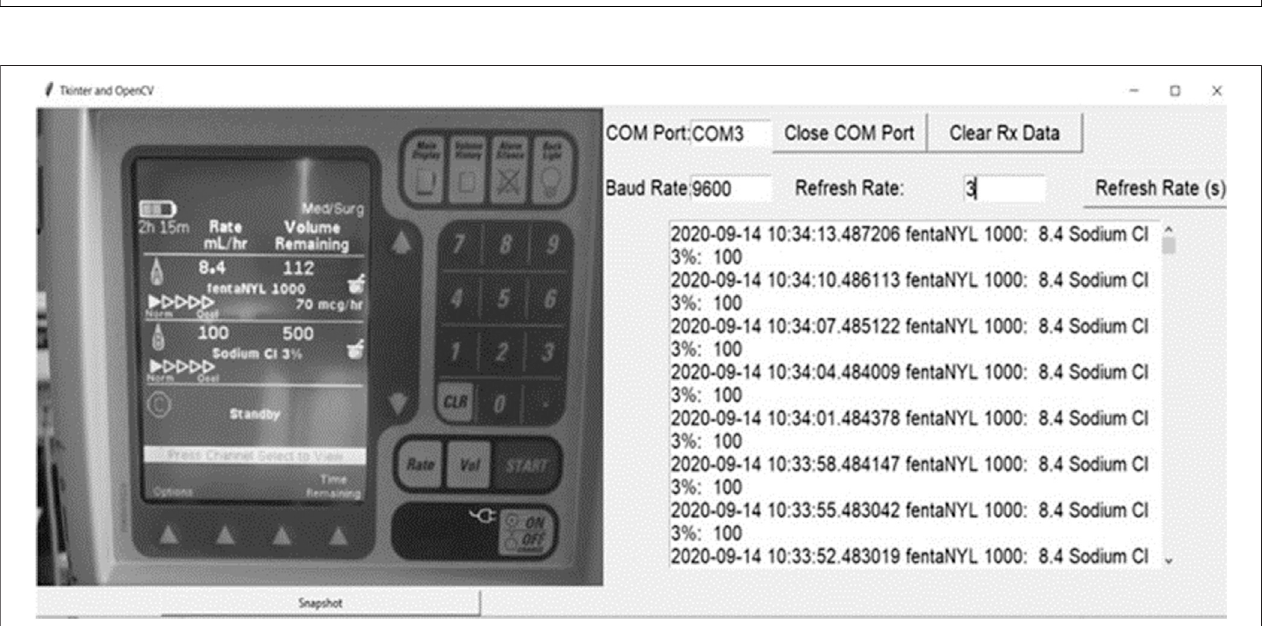
FIGURE2| Pythoninterface. LeftPanel – Displays digital photoofmedication pump taken bythecamera, Right Panel -Displays theinterface ofoursystem, with real time data being updated from the extracted features from the medication pump display.